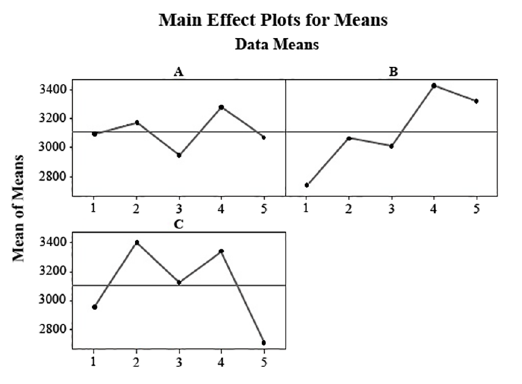
Figure 5. Main effect plots for tensile load for a (heating rate), T (temperature) and h